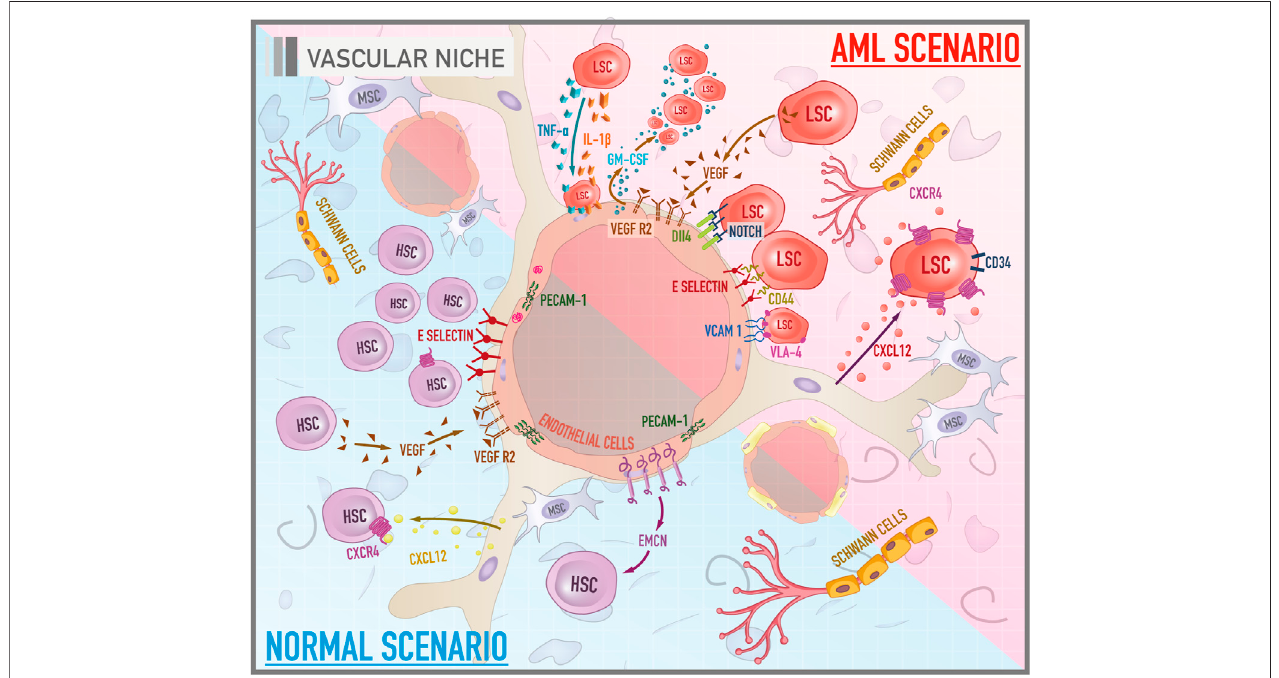
FIGURE2| Cellularandmolecularcomponentsofbonemarrowvascularnicheinbothhealthyandleukemicscenarios.Theillustrationcomparesthefunctioningof the vascular niche under a normal context and during leukemogenesis. In a physiological scenario, HSCs acquire a proliferative pro fi le and differentiated phenotype. PECAM-1 stabilizes the endothelial layer. EMCN, in turn, is a potential molecule related to angiogenesis. Another pathway associated with vessel morphogenesis is the VEGF/VEGFR.E-selectinactsasapromoterofHSCsproliferation.IntheAMLscenario,thereareimportantaxesthatmediatetheanchorageofleukemicstemcells (LSCs) to endothelial cells such as E-selectin/CD44 and VCAM-1/VLA-4. Signaling pathways such as VEGF/VEGFR and Notch/Dll4, in turn, are related to tumor angiogenesis. GM-CSF is a molecule with mitotic properties on LSCs, secreted by VEGF-stimulated endothelial cells. Cytokines, especially IL-1 beta and TNF-alpha, secreted by LSCs promote the attachment of these cells to the